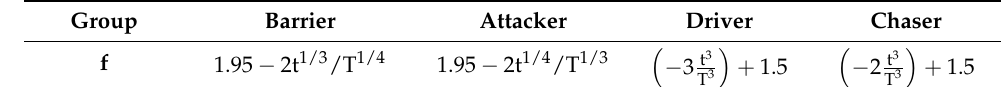
Table 1. Dynamic coefficient of f vector.